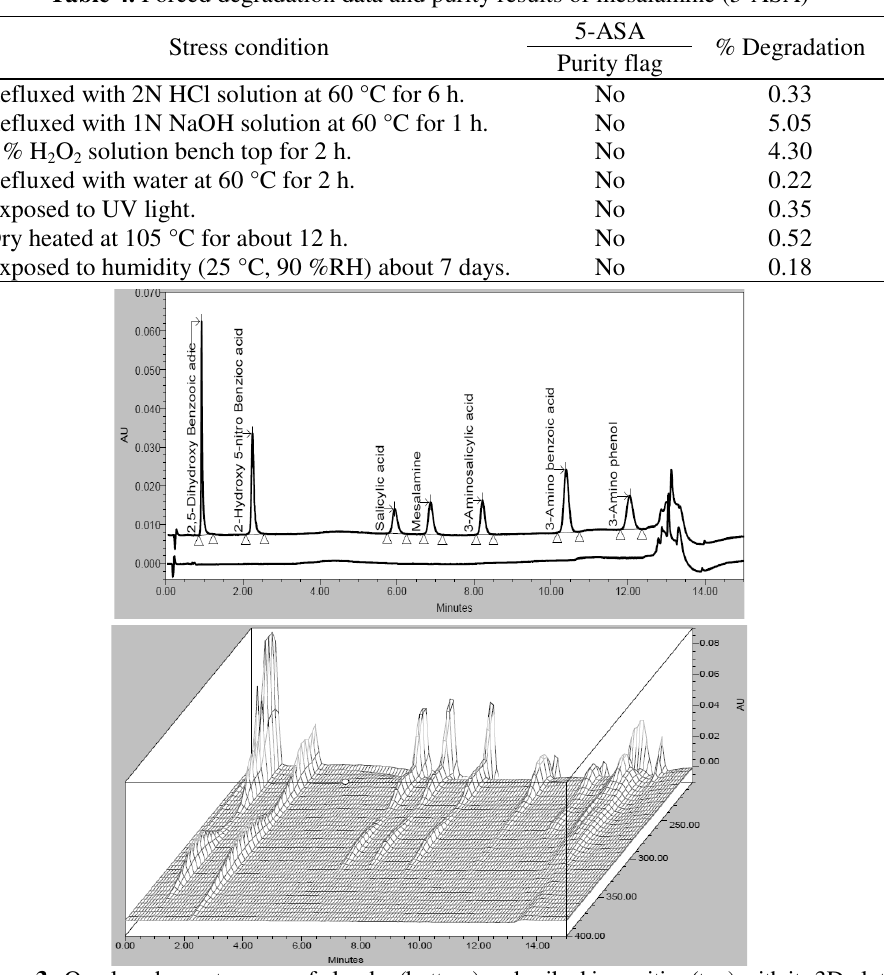
Figure 3. Overlay chromatograms of placebo (bottom) and spiked impurities (top) with its 3D plot